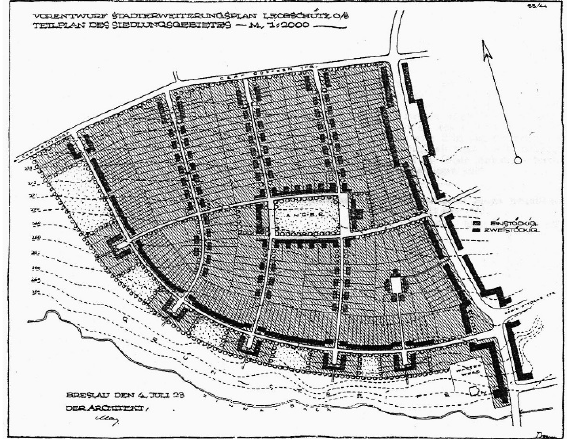
Figure 6. Site layout of Leobschütz Siedlung. Source: May (1923).